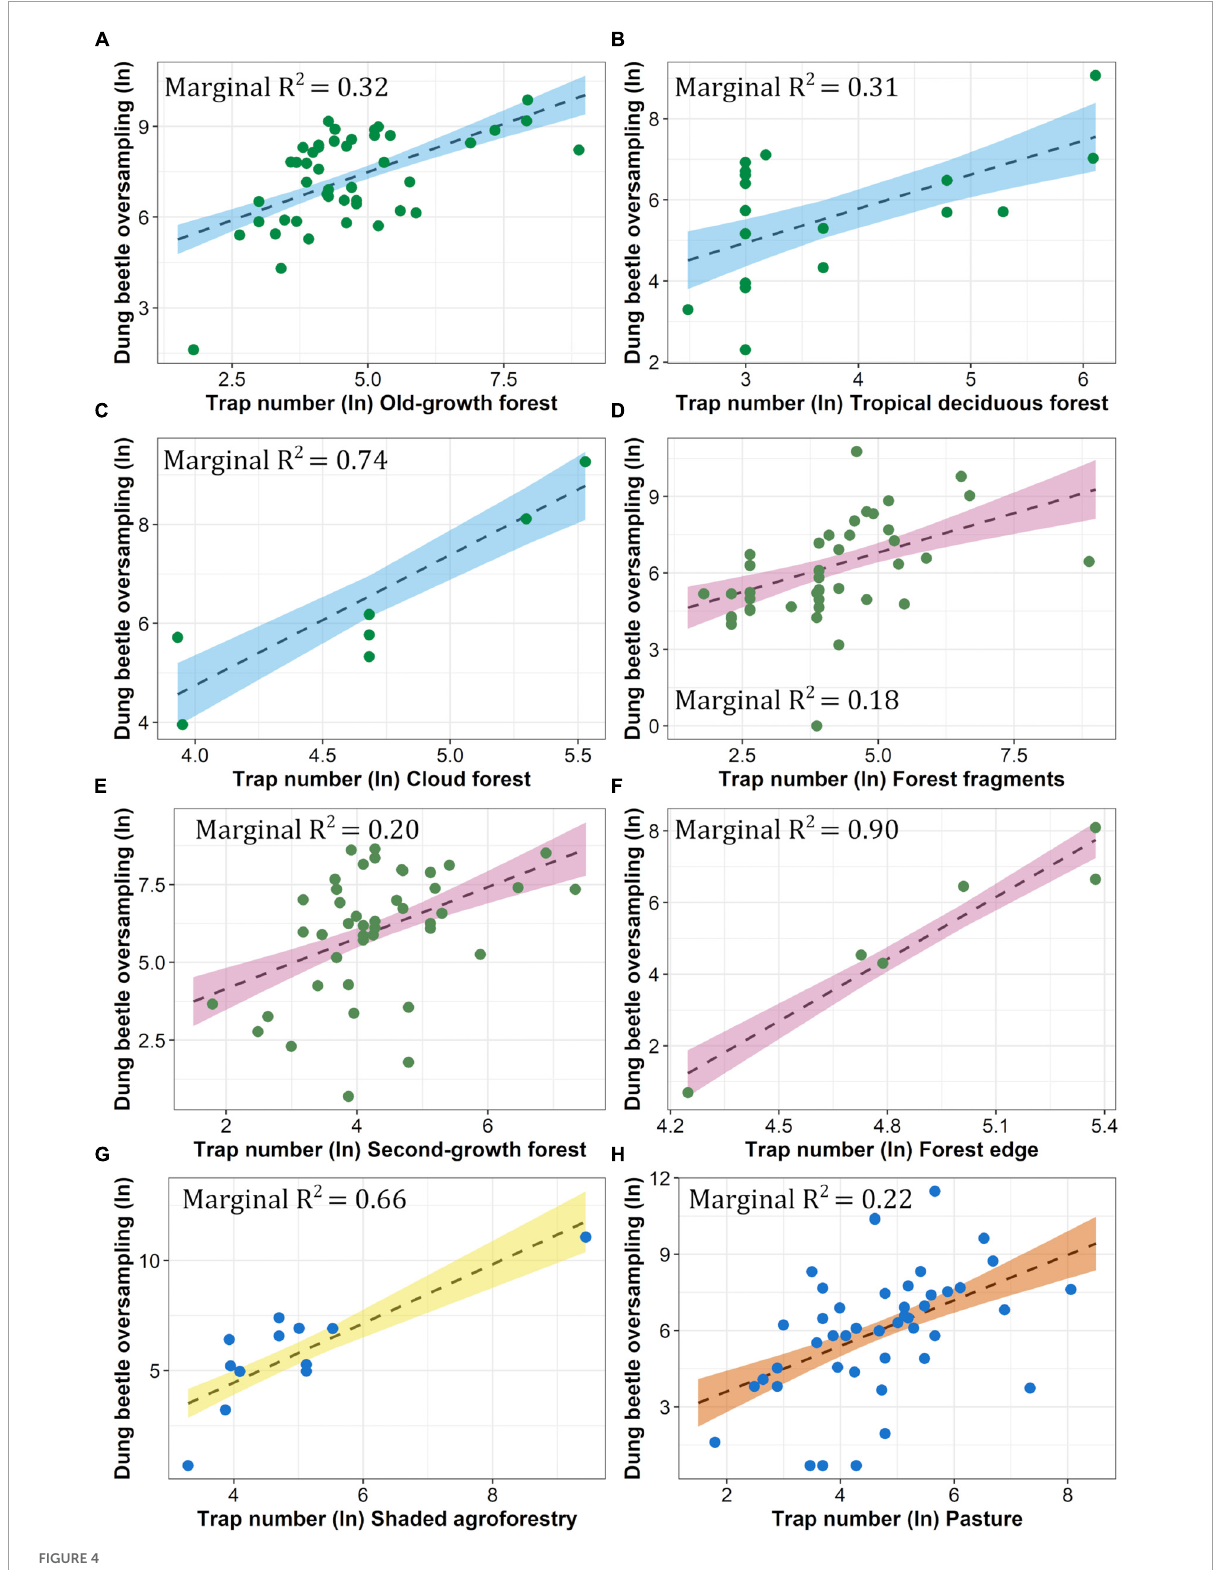
FIGURE4 Correlation between the log-transformed (ln) number of traps and dung beetle oversampling across habitat categories. (A) Old-growth forest, (B) tropical deciduous forest, (C) cloud forest, (D) forest fragments, (E) second-growth forest, (F) forest edge, (G) shaded agroforestry, and (H) pasture. The complete model results are shown in Supplementary Table 5A . Model fit and assumptions are shown in Supplementary Figure 3